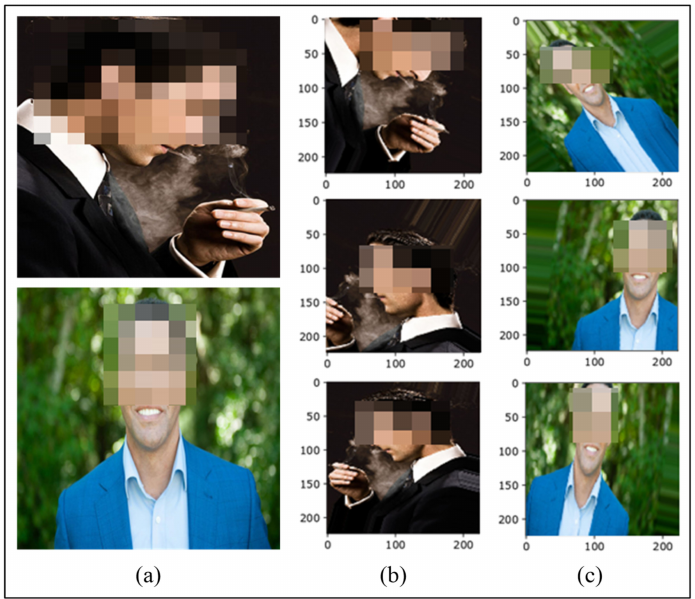
Figure 5. Images of ( a ) resized, random augmentations on ( b ) Smoking and ( c )